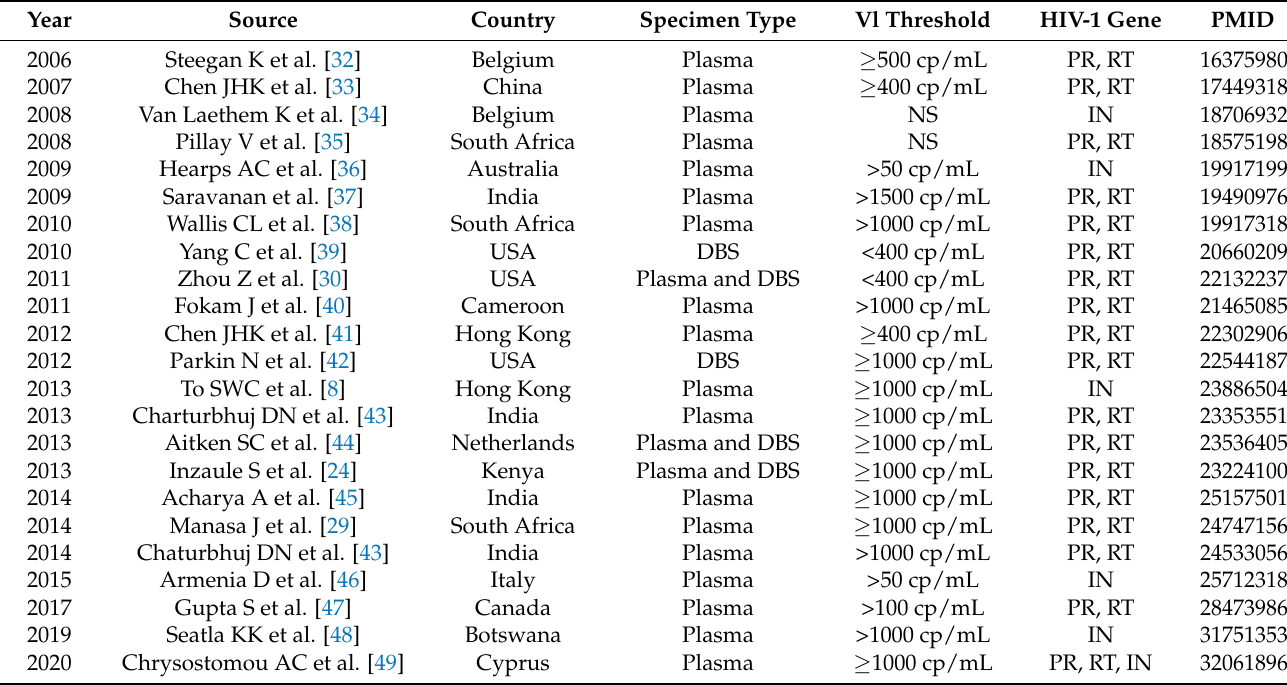
Table 2. In-house HIVDR genotyping assays for use in resource limited settings.